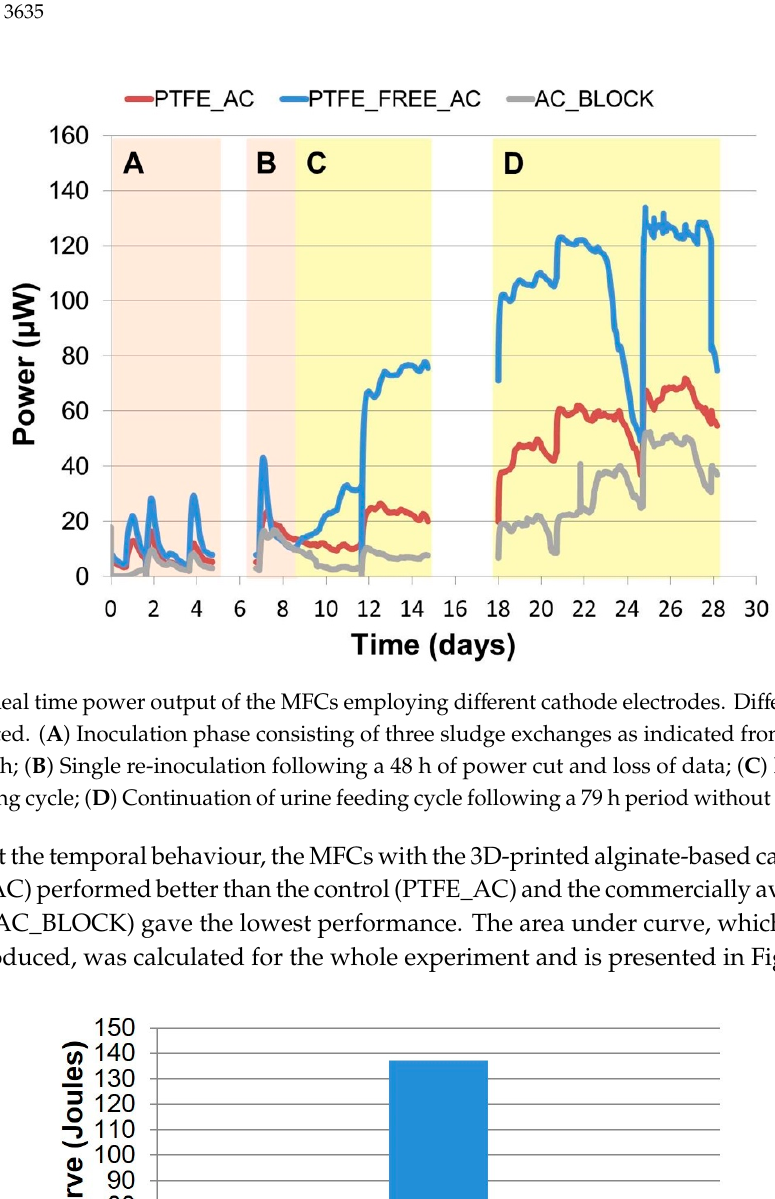
Figure 2. Overall calculated area under the curve, presented in Joules, based on the temporal power output data.